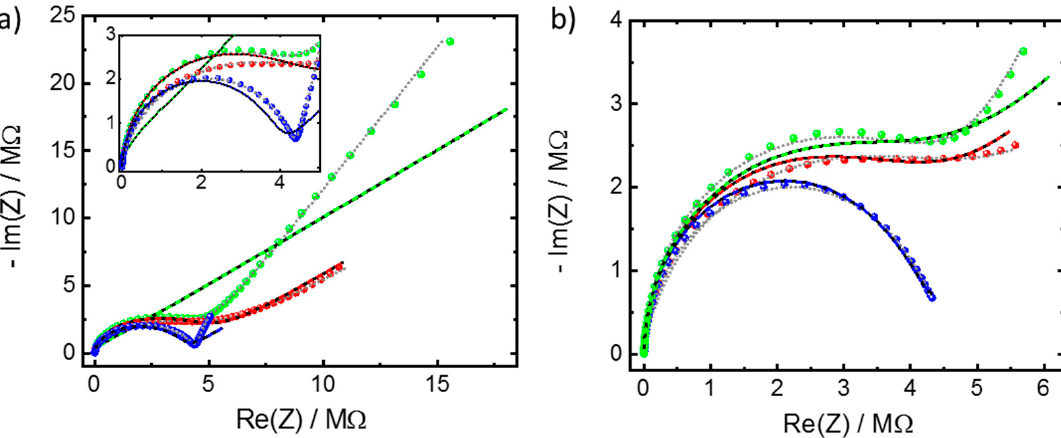
Figure A5. Nyquist plots of IL in HKUST-1 SURMOF films on substrate functionalized with MUD-SAM (green) MHDA- SAM (red) and with UV-ozone for 30 min (blue)—see Figure 5. The experimental data are shown as spheres, the grey-dotted lines are the fits with the ( R-CPE dl ) ‖ CPE geo . The black-color-dashed lines are the best fits by Randles equivalent circuit. The frequency range in panel ( a ) is 3.5 Hz to 5 MHz, and in panel ( b ) is 56 Hz to 5 MHz. Only the plotted data are used for the fitting by the models. Like in Figures A2 and A3, the major reason for the poor description of the experimental data by the Randles circuit is the fact that the Warburg resistance of the Randles equivalent circuit results in a low-fre- quency ray with an angle of 45° in the Nyquist plots, which is often not the case in the experimental data. This results in poor fits, especially when the low-frequency range is recorded, see panel ( a ).